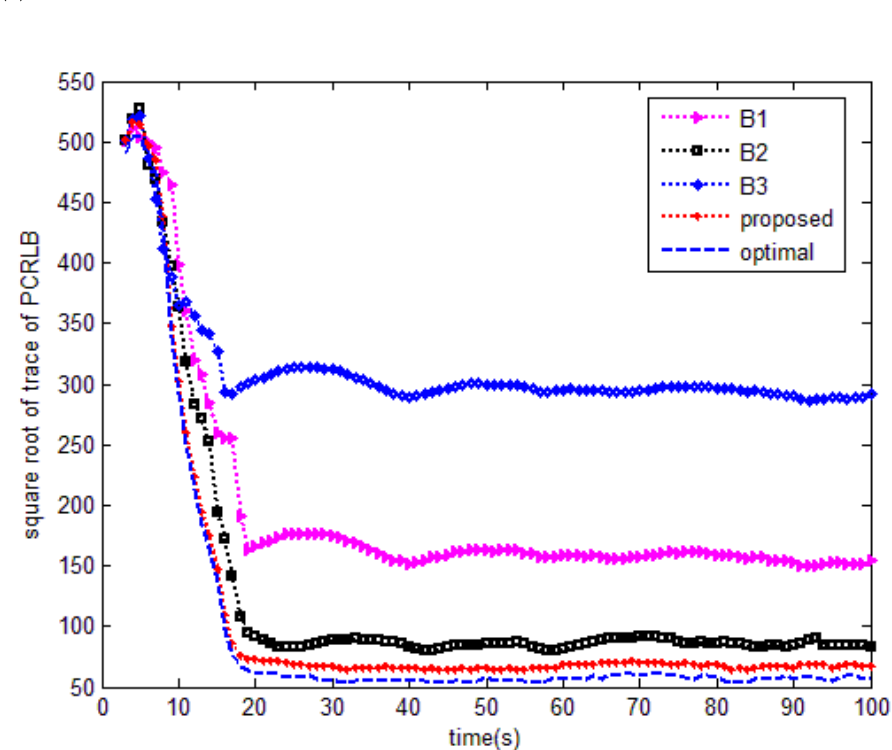
Figure 4. Comparison of the square root of trace of PCRLB.